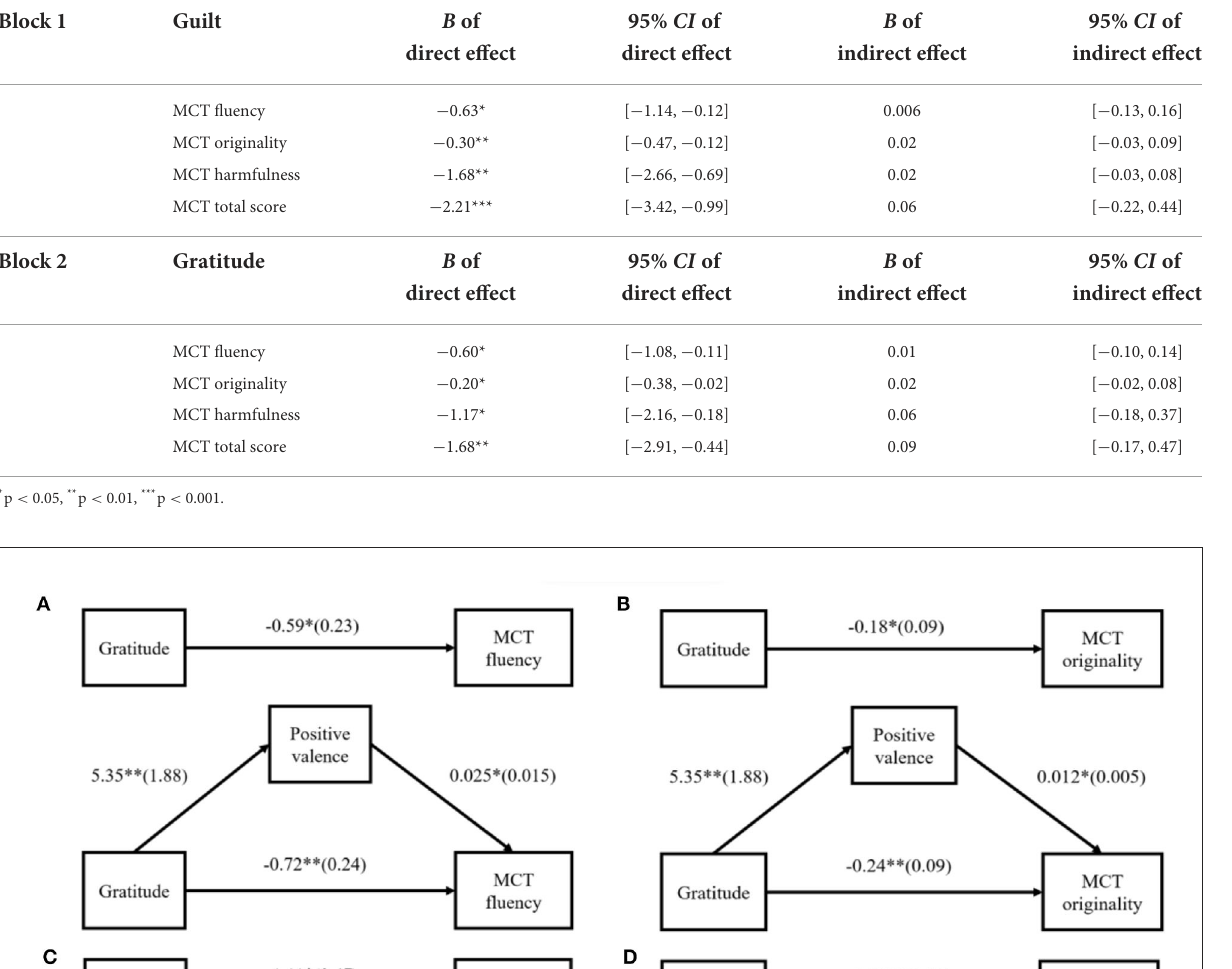
TABLE 2 Mediation analyses of prosocial behavior in guilt (block 1) and in gratitude (block